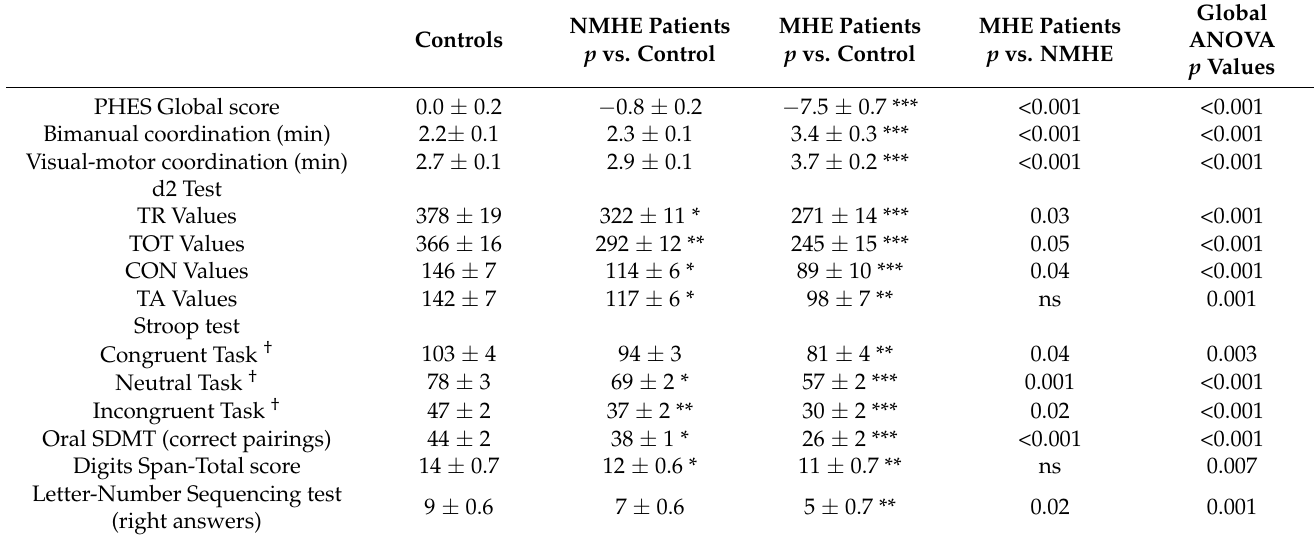
Table 2. Performance in neuropsychological tests.